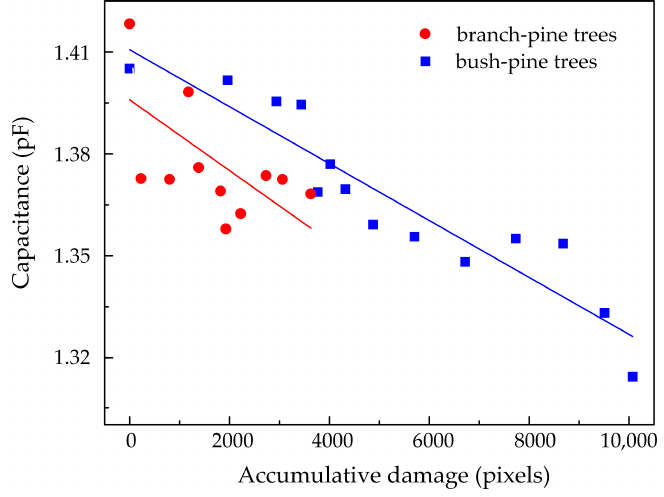
Figure 9. Capacitance at 50 MHz of 1 cm thick sliced samples during electrical tree growth.